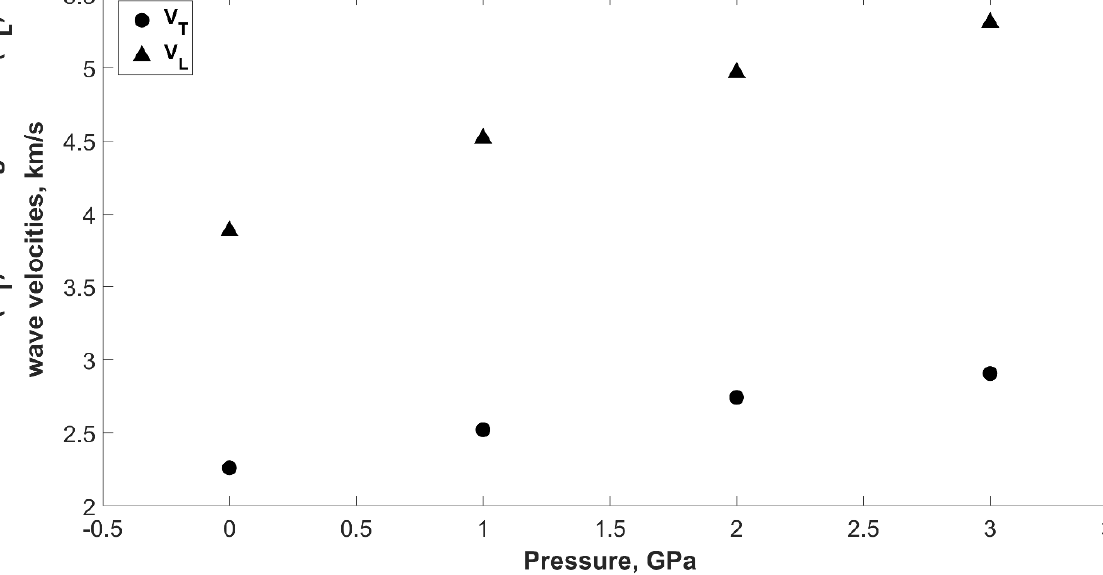
Figure 4. Pressure-dependent transverse (V T ) and longitudinal (V L ) wave velocities of CO 2 -NH sH gas hydrate at 0 K. Table 6. Transverse (V T ) and longitudinal (V L ) wave velocities of empty and Xe-NH sH gas hy- drates under pressure and at 0 K.